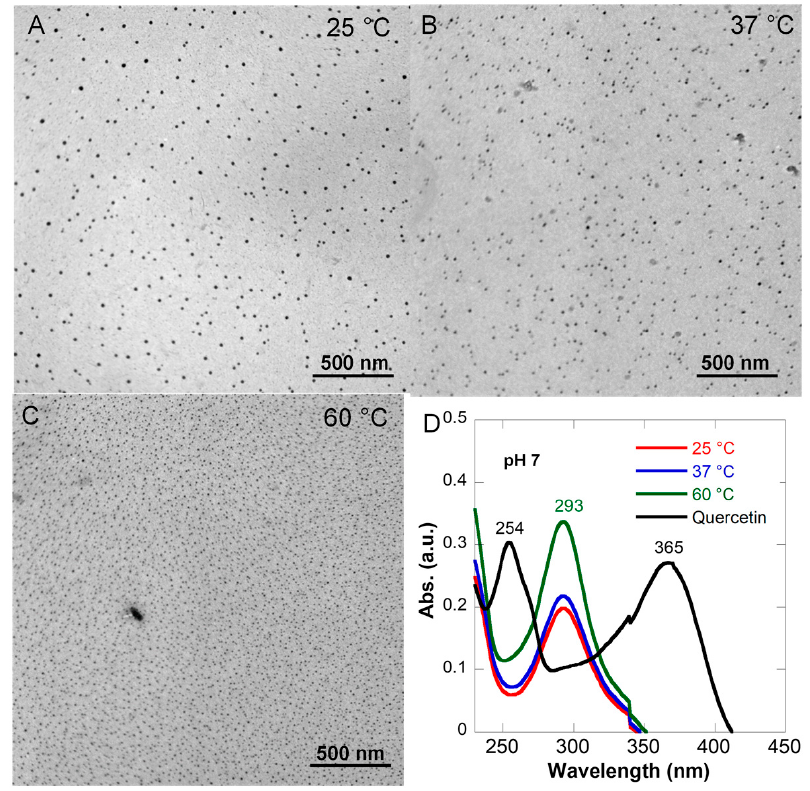
Figure 2. TEM images of QFeNPs prepared with a Q-Fe ratio of 1:5 at different temperatures: ( A ) 25 °C, ( B ) 37 °C, and ( C ) 60 °C, and ( D ) UV-Vis spectra of QFeNPs compared with free Q.